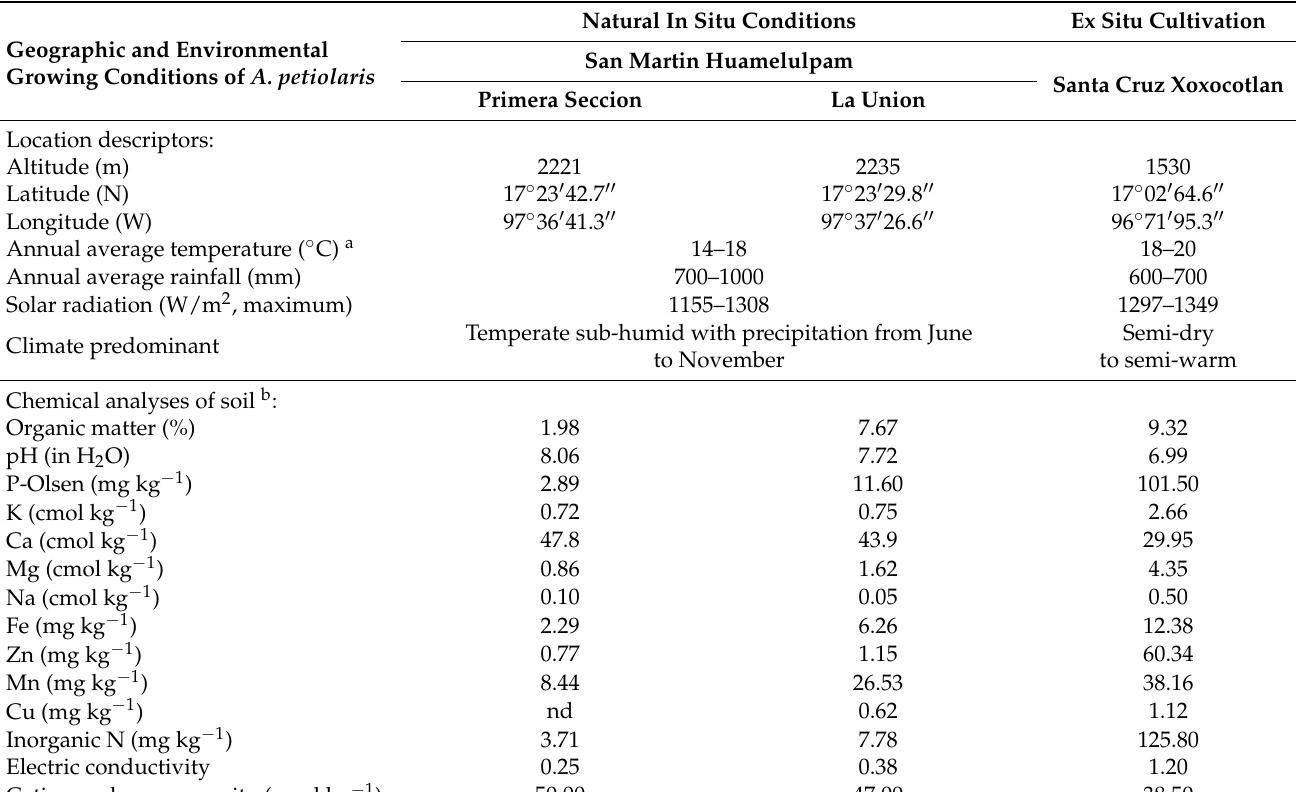
Table 1. Geographic and environmental growing conditions of A. petiolaris evaluated from Oaxaca,